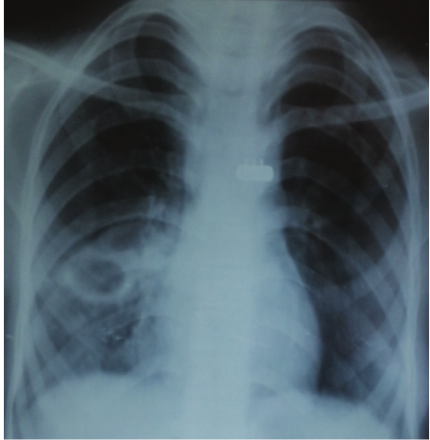
Figure 3: Chest X-ray showing far advanced lesion with cavity more than 4cm in